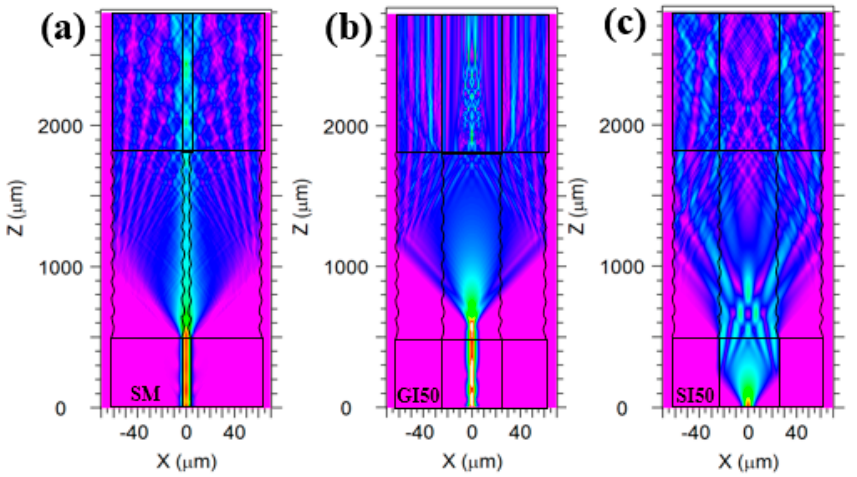
Figure 2. The simulation results of beam transmission path in different types of twisted fiber: ( a ) single − mode twisted fiber; ( b ) graded index multimode twisted fiber; ( c ) step − index multimode twisted fiber.